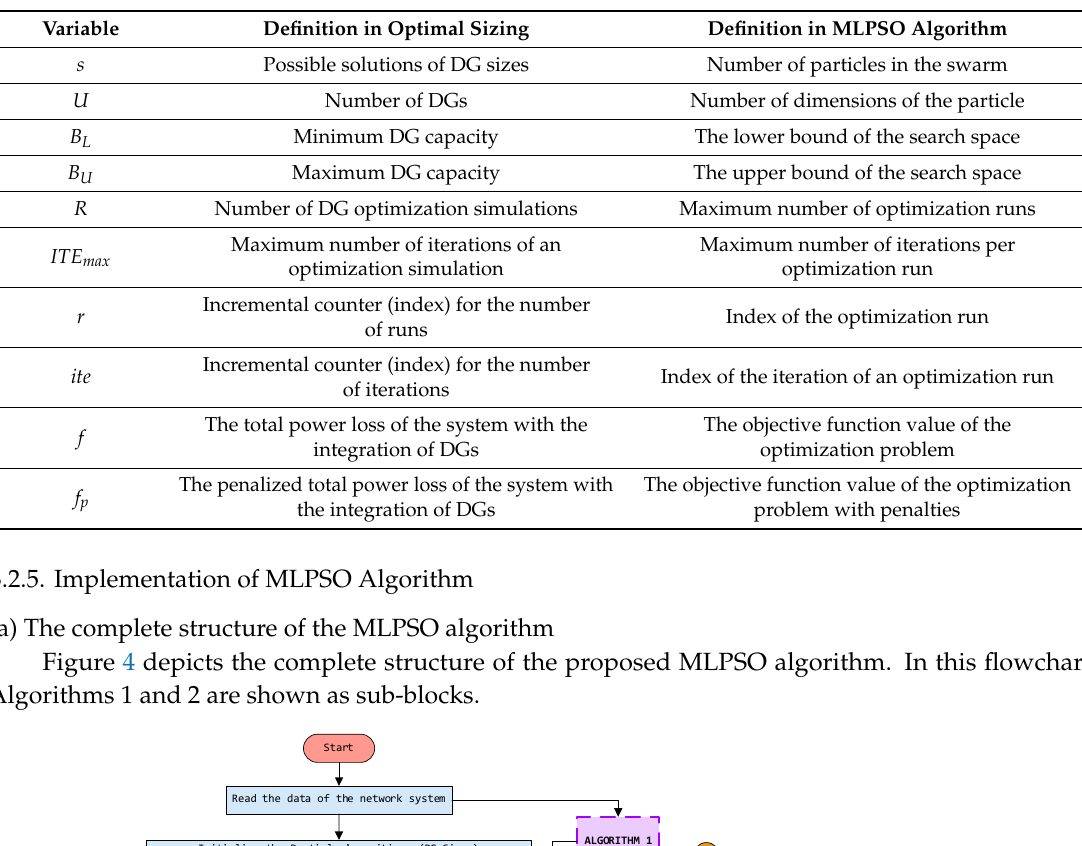
Table 1. Mapping the definitions of the problem.